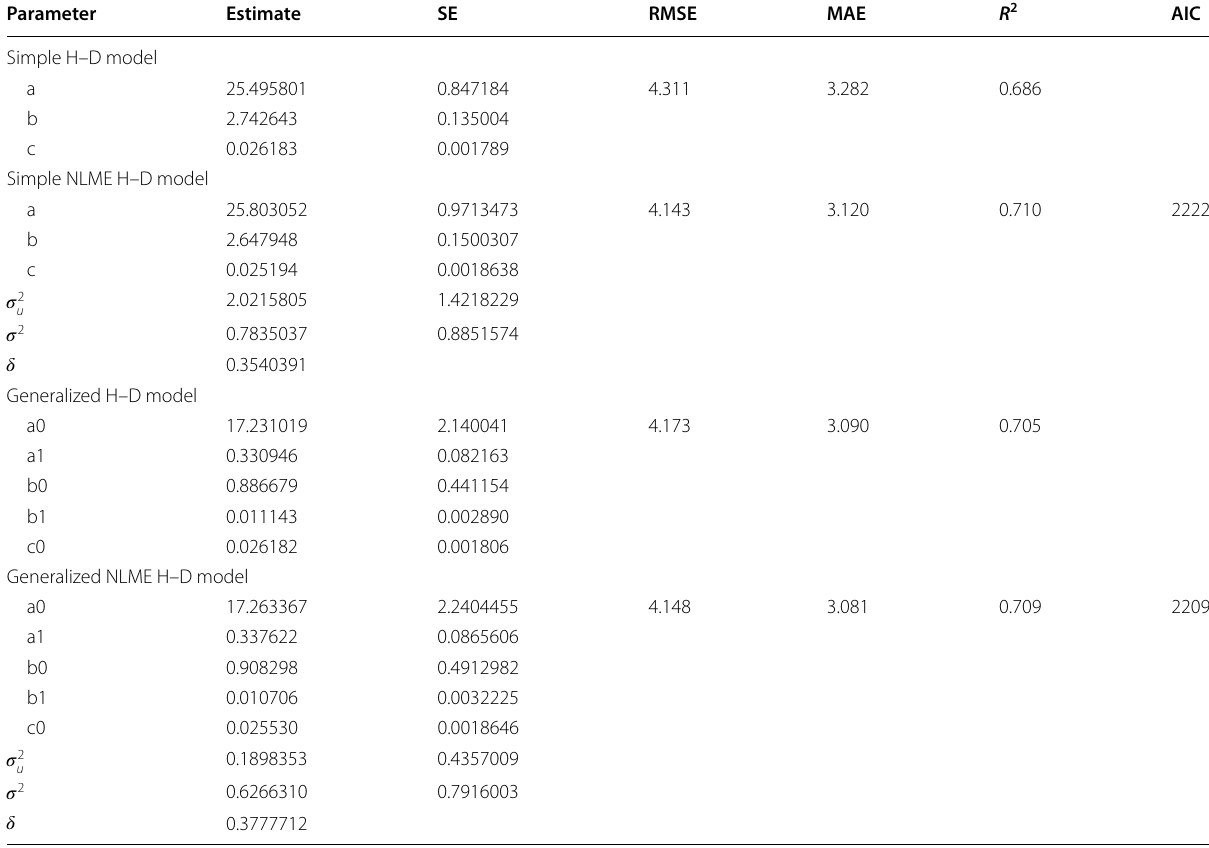
Table 6 Estimated parameters and goodness of fit of the H–D models for A. araucana , developed on the basis of the fitting database. For estimates for the models fitted to the complete database, see Table 15 in Appendix Parameter